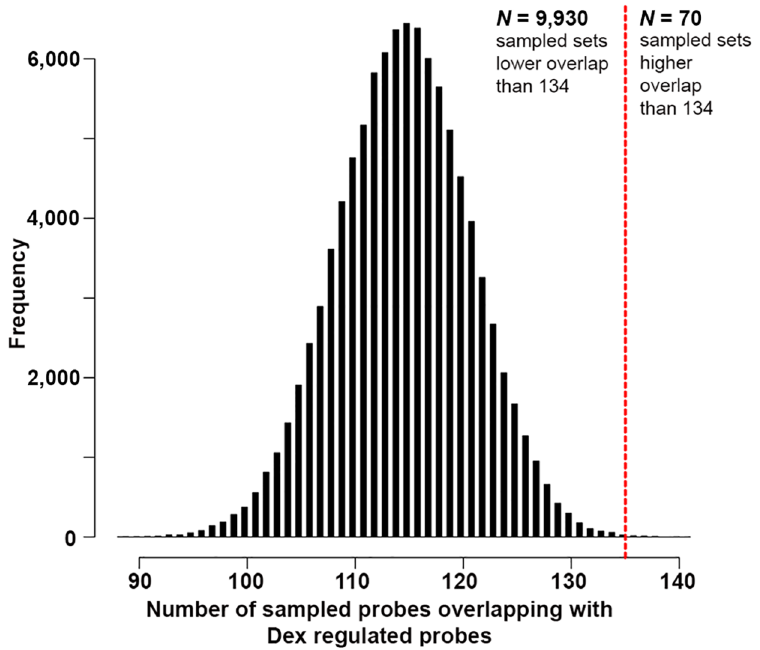
Fig 6. Enrichment of dexamethasone-regulated genes. Histogram of 100,000random samples indicates that paroxetineresponsegenes show higheroverlap with dex-regulated genes than expectedby chance. The overlap betweendifferential microarray probesfrom paroxetine-responseand dex-regulated microarraysis 134 and this thresholdis indicatedas a vertical red dashedline. In this simulation, on average, 115 probes do overlap by chance and in 70 samples, the randomoverlap is higherthan the tested one. All raw data for Fig 6 are availablein S1 Data. dex, dexamethasone.